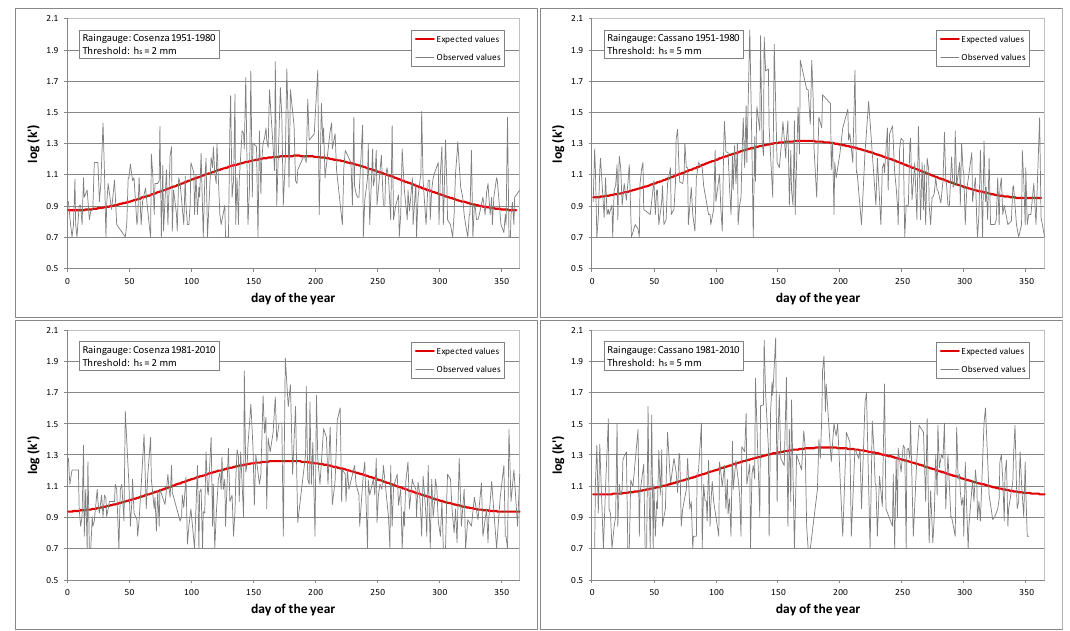
Figure 3. Expected and observed values of the dry spells sequences k with thresholds 2 mm for the Cosenza rain gauge and 5 mm for the Cassano rain gauge in the 30-year periods 1951–1980 and 1981–2010. The statistical behavior of the Fourier parameter 𝑎 (cid:2868)∗ for the different threshold values in both the 30-year periods for all the rain gauges revealed a high degree of regularity in a proper scale (Figure 4).